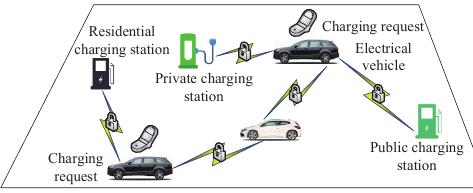
Figure 15. The architecture of the matching